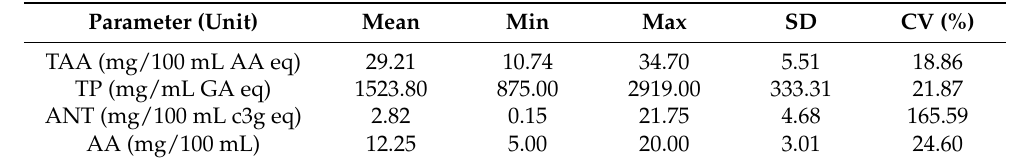
Table 4. Descriptive statistics of the biochemical features of the 40 pomegranate